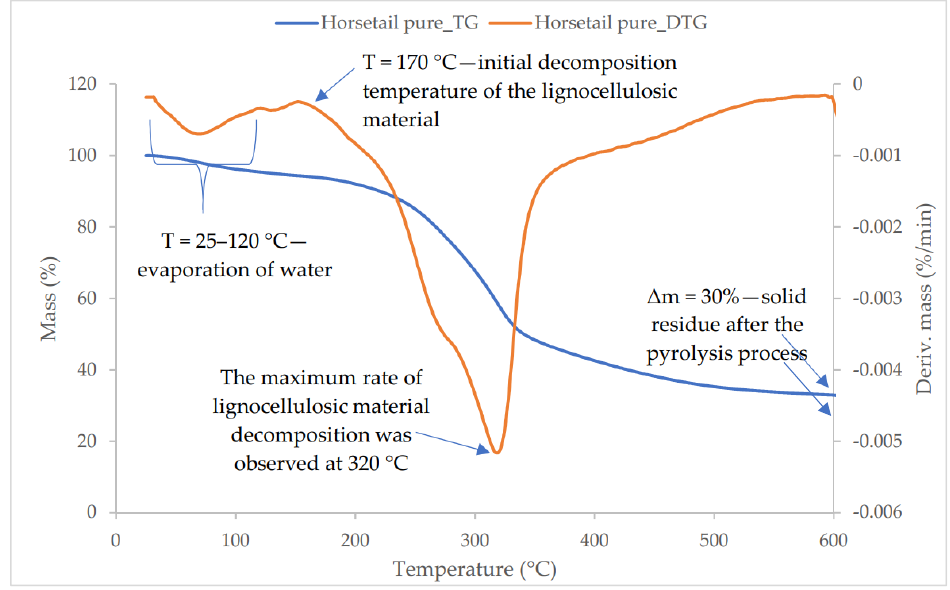
Figure 2. The thermogravimetry (TG) and derivative thermogravimetry (DTG) curves of the horsetail powder.